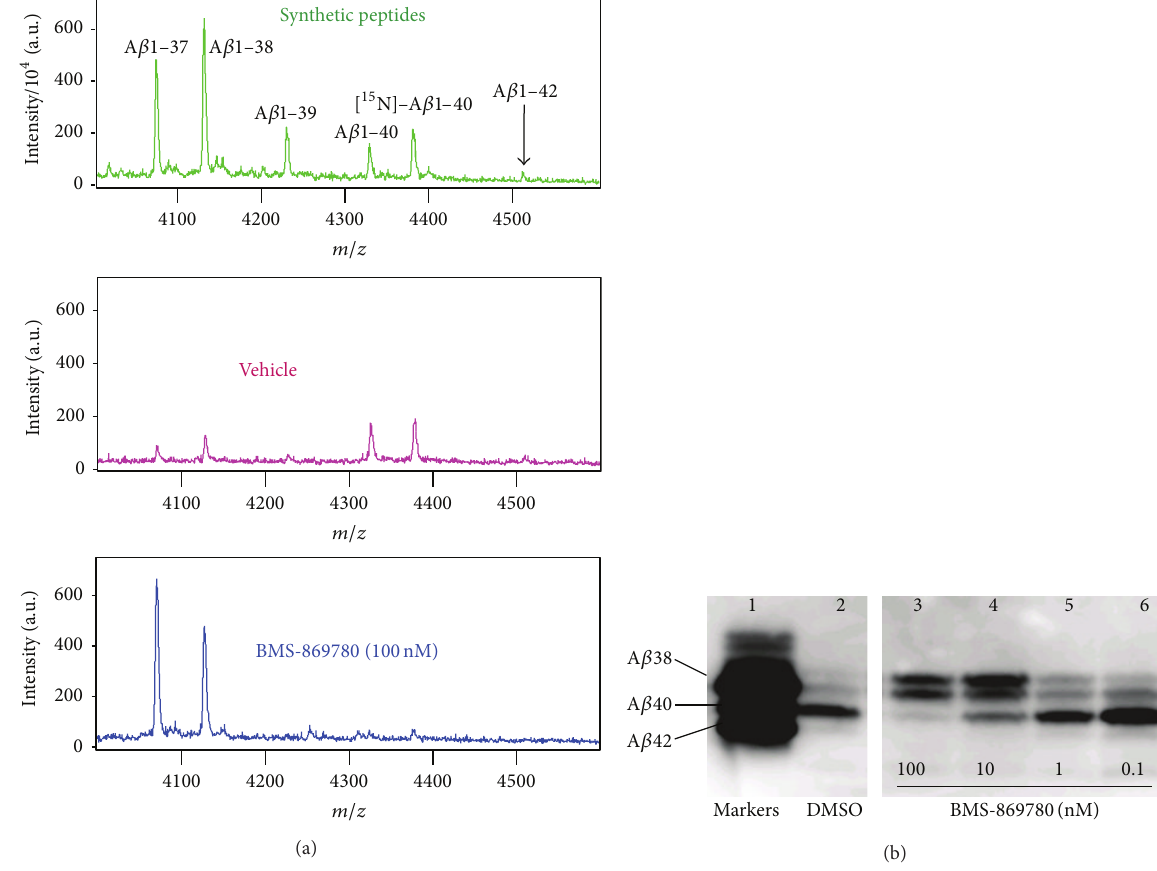
Figure 3: BMS-869780 increased the levels of the shorter peptides A 𝛽 1-38 and A 𝛽 1-37. (a) Top panel: an equimolar mix of synthetic peptides A 𝛽 1-37, A 𝛽 1-38, A 𝛽 1-39, A 𝛽 1-40, [ 15 N]-A 𝛽 1-40, and A 𝛽 1-42 was evaluated by MALDI-TOF mass spectrometry. H4-APPsw cell cultures were treated with vehicle (0.1% DMSO—middle panel) or BMS-869780 (100nM—bottom panel), [ 15 N]-A 𝛽 1-40 was added, and A 𝛽 peptides were